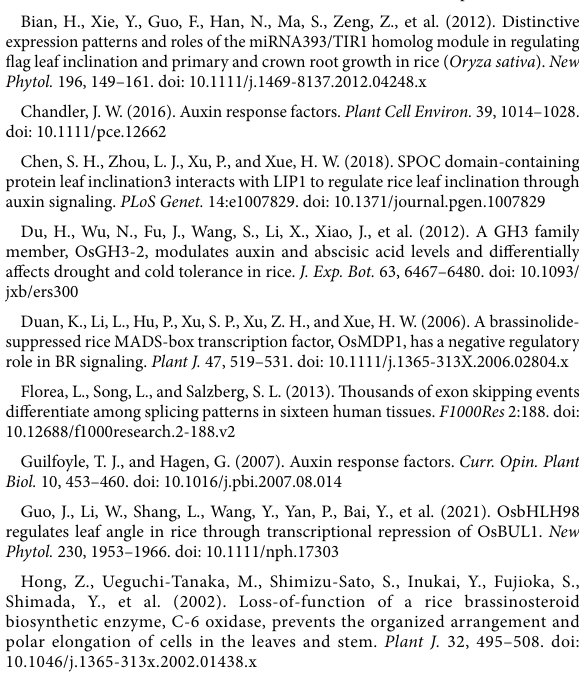
SUPPLEMENTARY FIGURE 1 Nuclear localization of OsARF4 in root cells. 35S:OsARF4-GFP was transformed into WT/DJ. Green fluorescence represents the nucleus of the root tip cell; bar scale = 20 μ m. SUPPLEMENTARY FIGURE 2 Relative expression of OsARF4 in OsARF4 -overexpressing lines. qRT-PCR was performed using the LJs of each line for three individual biological replicates. * P < 0.05 and ** P < 0.01, t -test. SUPPLEMENTARY FIGURE 3 OsARF4 expression under auxin treatments. Seven-day-old of WT/DJ seedlings were grown in a solution containing 10 μ m NAA and 1 μ m 2,4-D for 0, 3, 6, 9, and 12 h. ( n = 3) ** P < 0.01 indicates significant differences compared with 0 h using Student’s t -test. SUPPLEMENTARY FIGURE 4 Expression profiles of hormone-related genes in RNA-seq in LJs of WT/ DJ, osarf4 -1 and OE-OsARF4-1 line. SUPPLEMENTARY FIGURE 5 OsARF4 is expressed in primary root, lateral root and coleoptile of pro:OsARF4-GUS transgenic seedlings. (A) GUS staining of 3-d-old primary root, lateral root and coleoptile of pro:OsARF4-GUS transgenic seedlings. Bar scale = 500 μ m. (B) qRT-PCR analysis of OsARF4 expression in 3-d-old primary root, lateral root and coleoptile. Error bars represent SD ( n = 3). Lowercase letters represent significance according to Duncan’s multiple range test ( 𝛼 = 0.05). SUPPLEMENTARY FIGURE 6 Heat map of the RNA-seq analysis of genes involved in cell division and auxin signaling in LJs. SUPPLEMENTARY TABLE 1 Primers used for vector construction. SUPPLEMENTARY TABLE 2 Primers used for